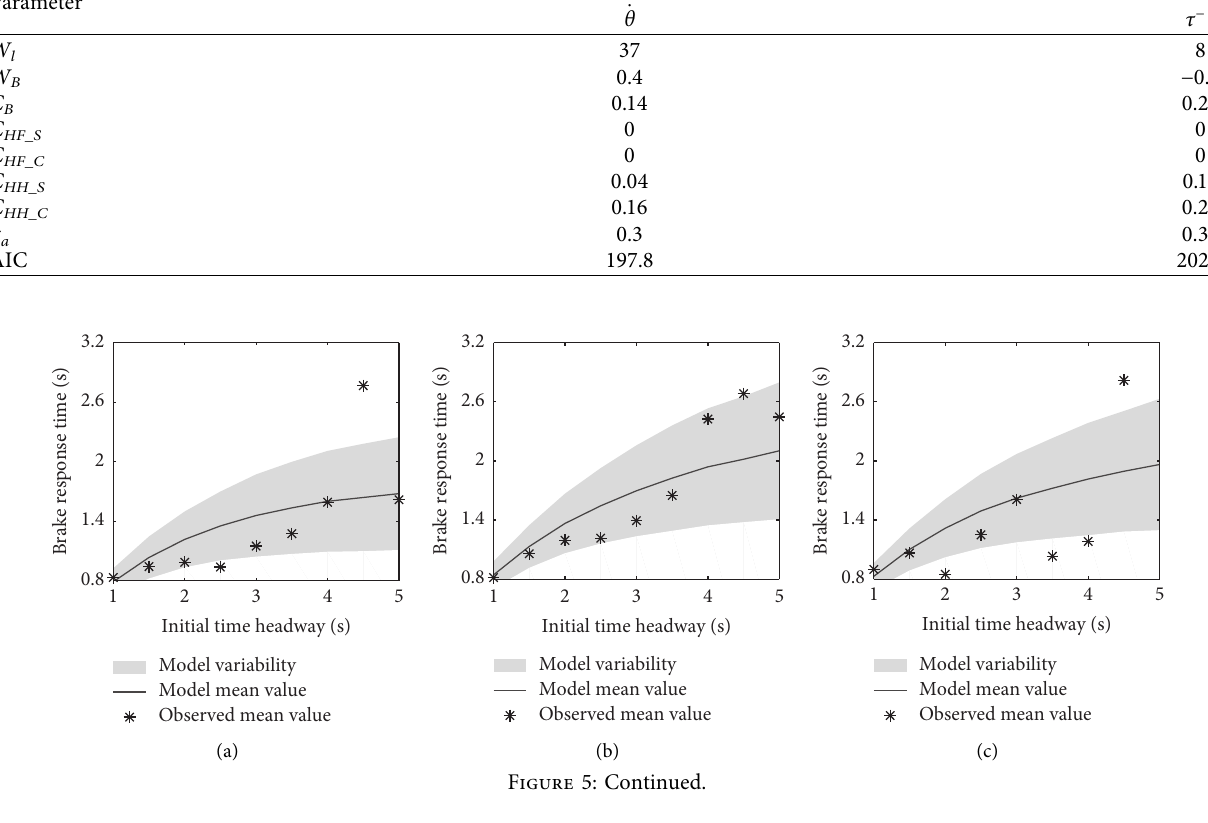
Figure 4: Drivers’ brake response times as a function of time headway, in the first braking scenario. (a) No phone N � 23. (b) Hhands-free Table 3: Best parameterisation for accumulator model using _ θ and τ − 1 , for the first braking scenario.